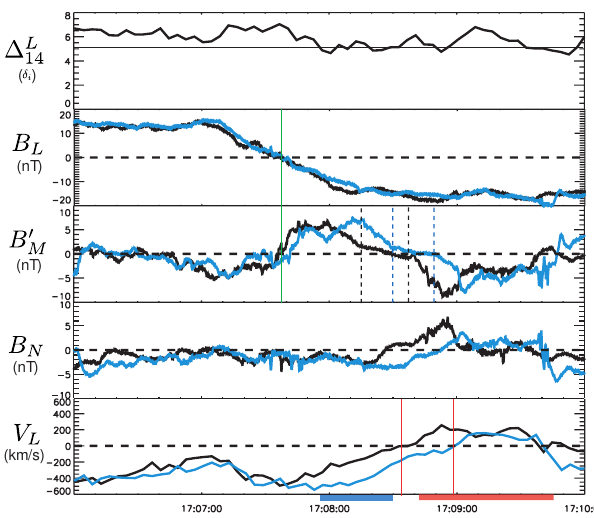
Fig.4. Fromtopto bottom : Separation between Cluster1 and Cluster4 along the L direction measured in Fig. 4. From top to bottom: separation between Cluster 1 and Clus- localprotoninertiallengthunit, B L , B ′ M and B N magneticcomponents and V L component oftheprotonbulk ter 4 along the L direction measured in local proton inertial length flow measured as a function of time for Cluster1 (black) and 4 (blue). The green line indicates the time t BL . unit, B L , B 0 and B N magnetic components and V L component of The black and blue dashed lines indicate t C 1 B and t C 4 B , respectively. The red lines indicate indicate the flow M the proton bulk flow measured as a function of time for Cluster 1 reversalsat t VL 1 and t VL 4 . (black) and 4 (blue). The green line indicates the time t BL . The black and blue dashed lines indicate t C 1 and t C 4 , respectively. The B B red lines indicate indicate the flow reversals at t VL 1 and t VL 4